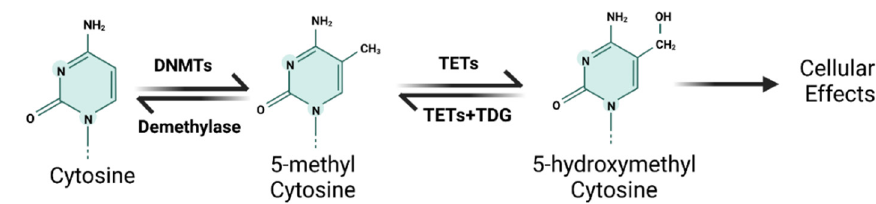
Figure 1. The schematic diagram of DNA methylation and demethylation mechanism.